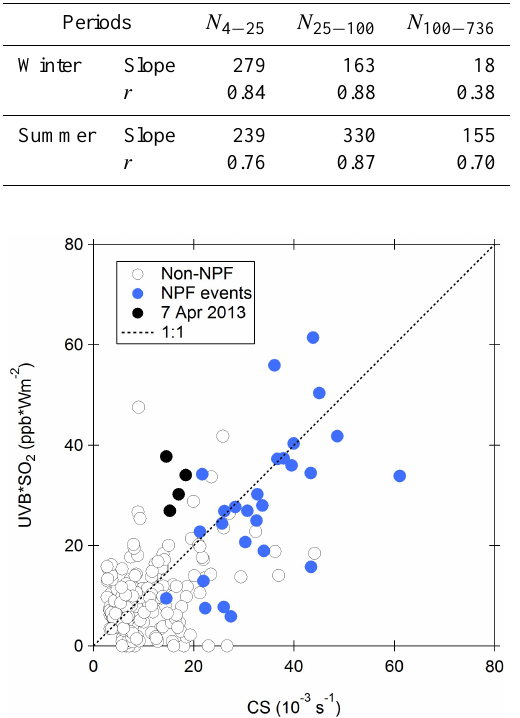
Figure 7. Scatter plot of hourly average UVB · SO 2 versus conden- sation sink at noontime (10:00–14:00LT).